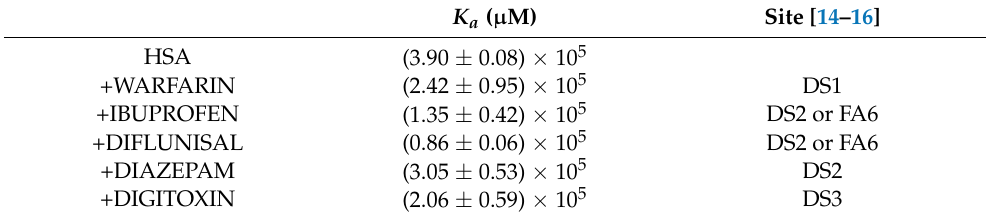
Table 1. Values of the association constant of the RB and the effect of pharmaceutical